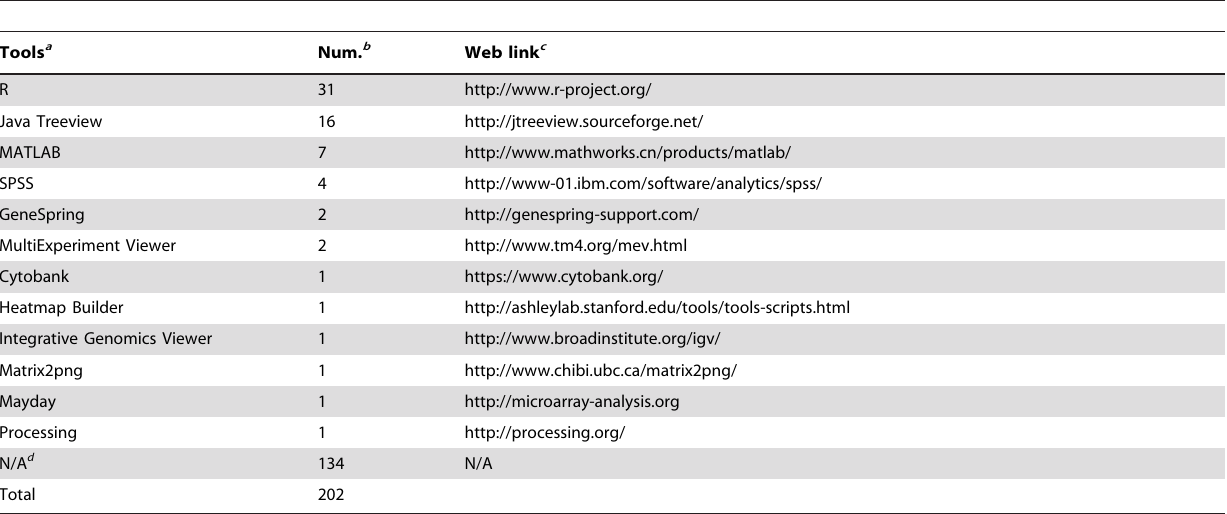
Table 2. The summarization of the methods for illustrating heatmaps among the 202 papers published in 2012 on five leading